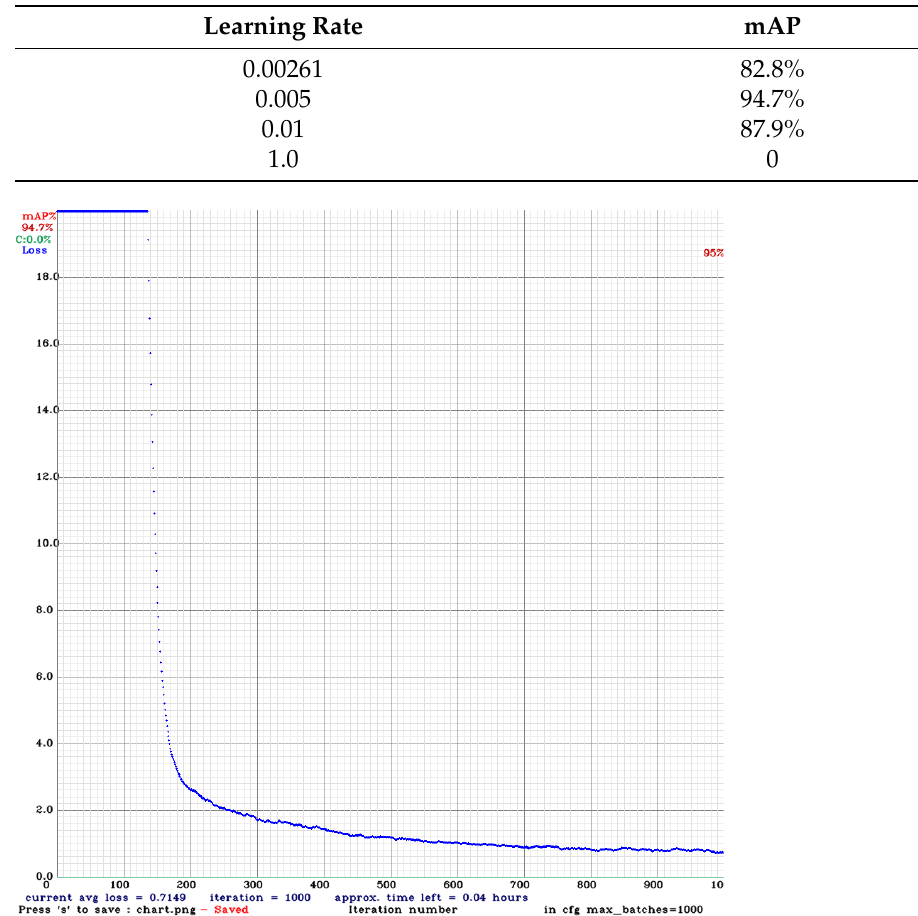
Table 7. Learning rate selection.